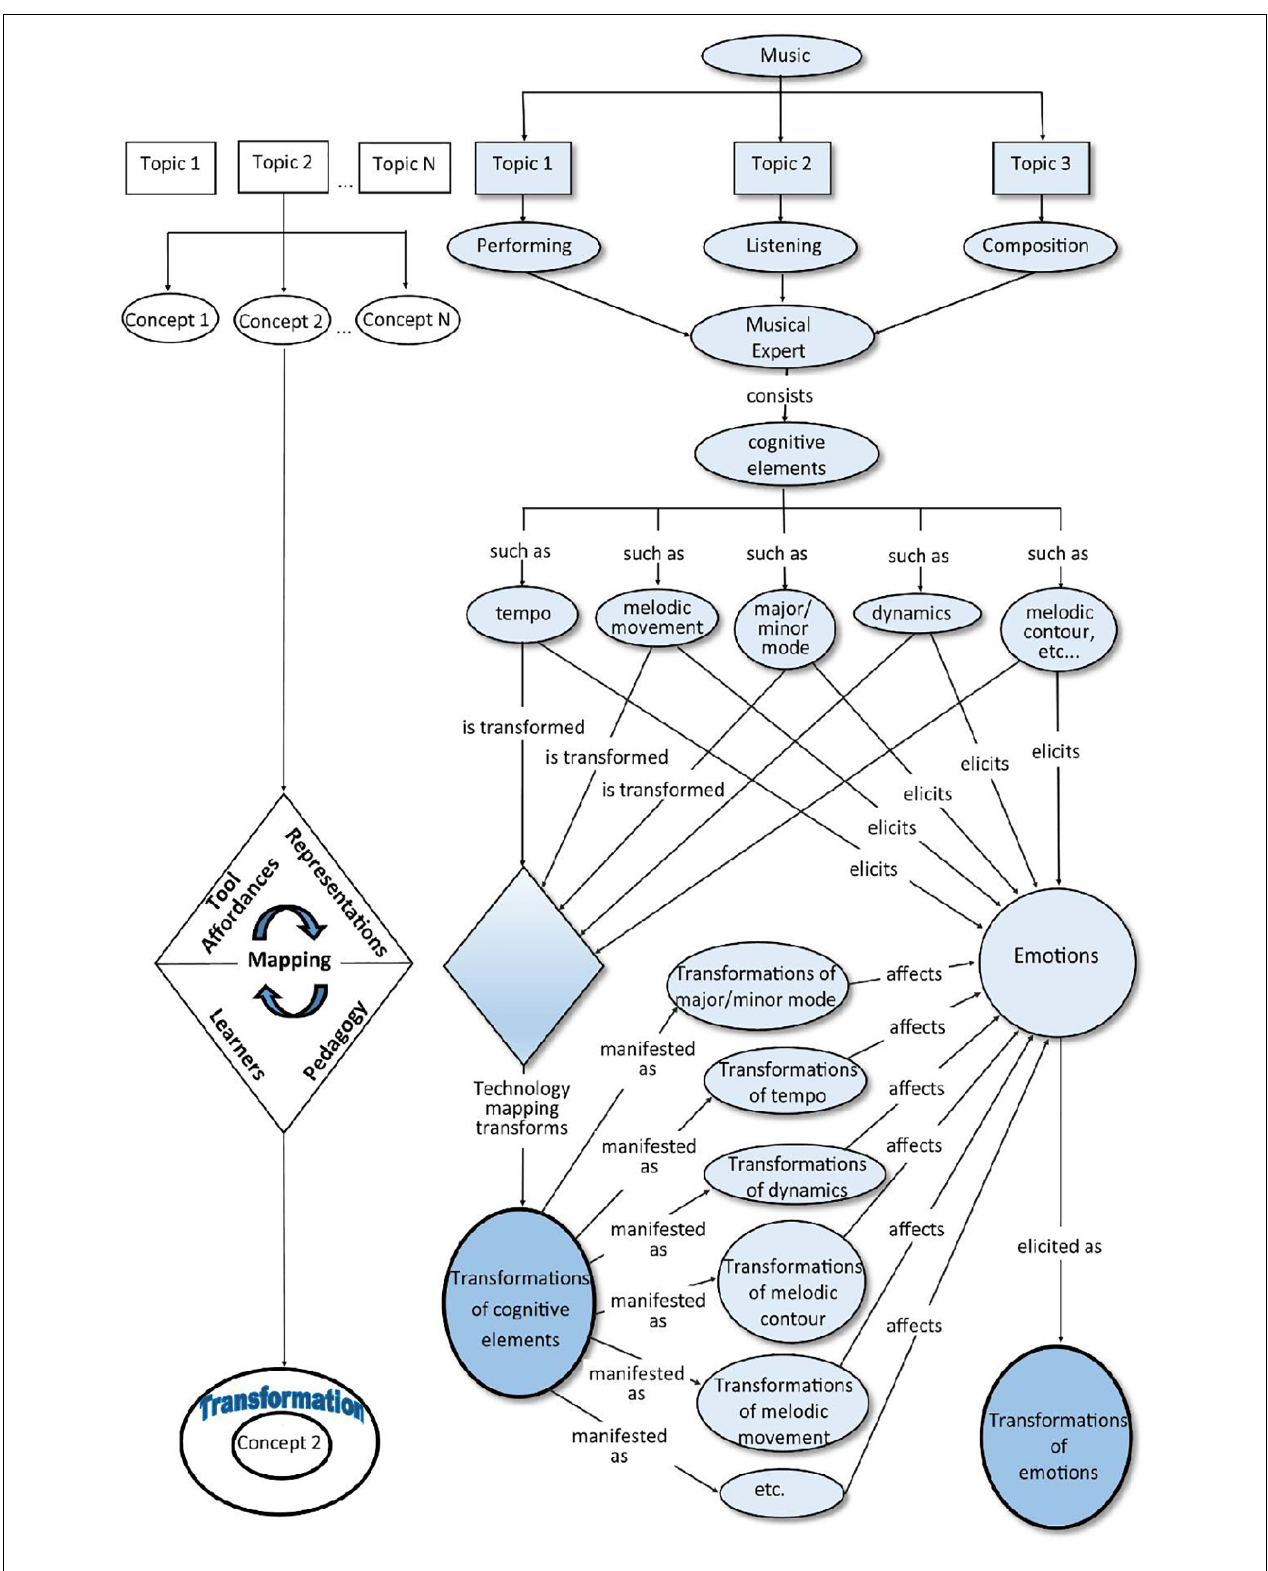
FIGURE 5 | An expanded model of Technology Mapping showing the interrelations of musical elements and concepts, technology, and affect (adopted from Macrides and Angeli, 2018a,b).